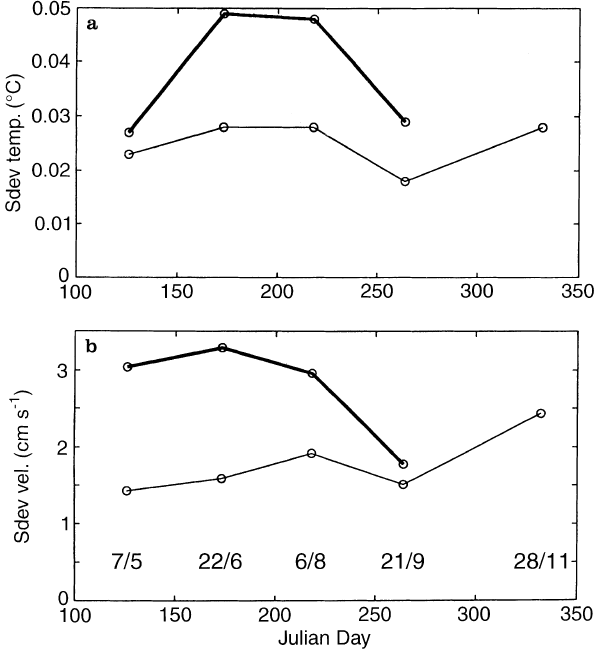
Fig. 10a, b. Standard deviation time-series of a temperature and b current speed measured in 45.5-day blocks from the 20–30-h filtered data at SW ( thick ) and NE ( thin